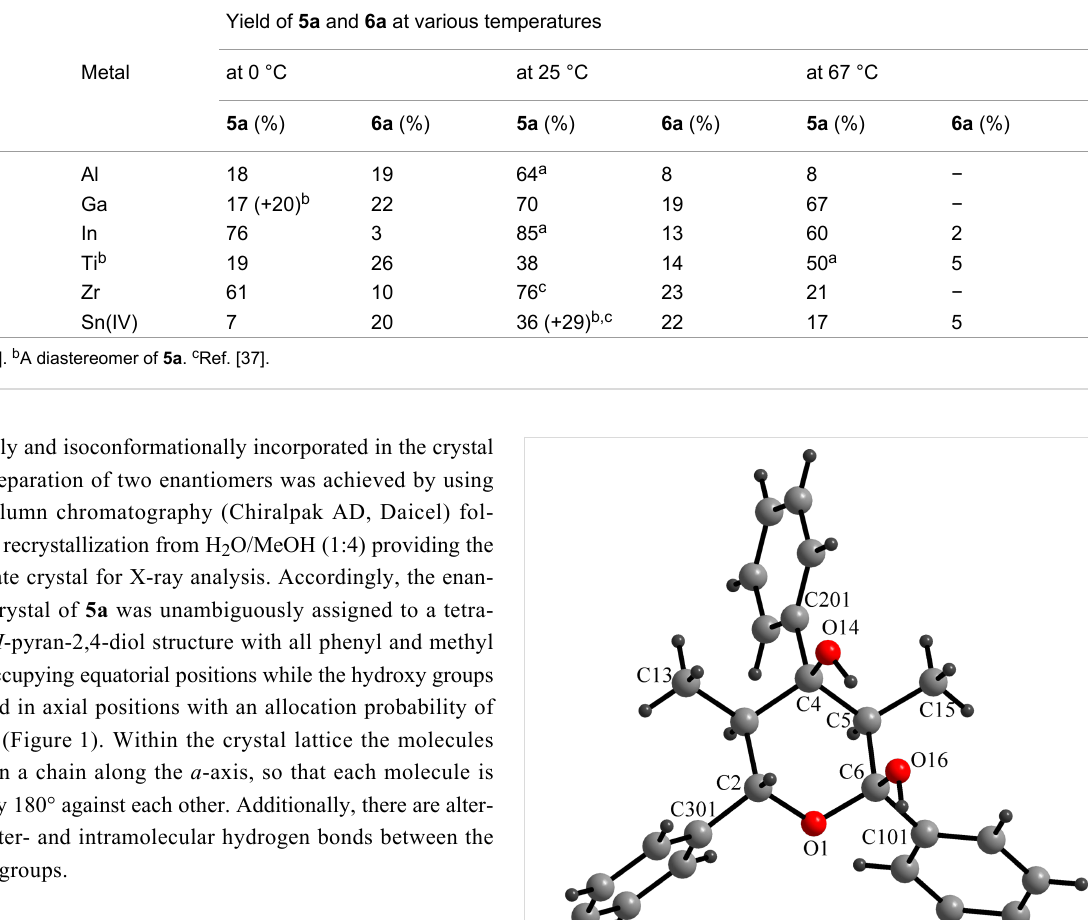
Table 1: Effect of metals on the domino aldol reaction of 1a and 3a at different temperatures (reaction time: 2 h) on the yield of 5a and 6a .